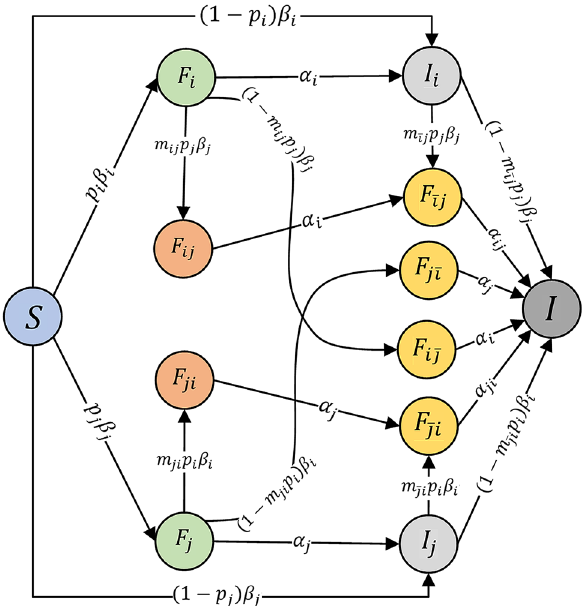
Figure 3. Cross-transmission flow chart for